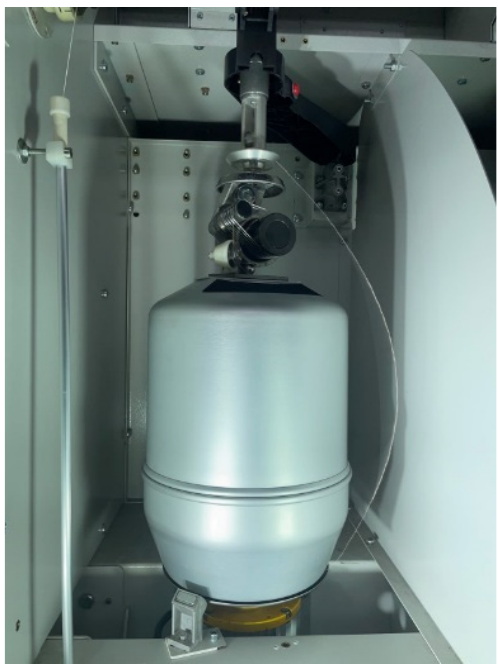
Figure 4. Transient shape of the balloon.